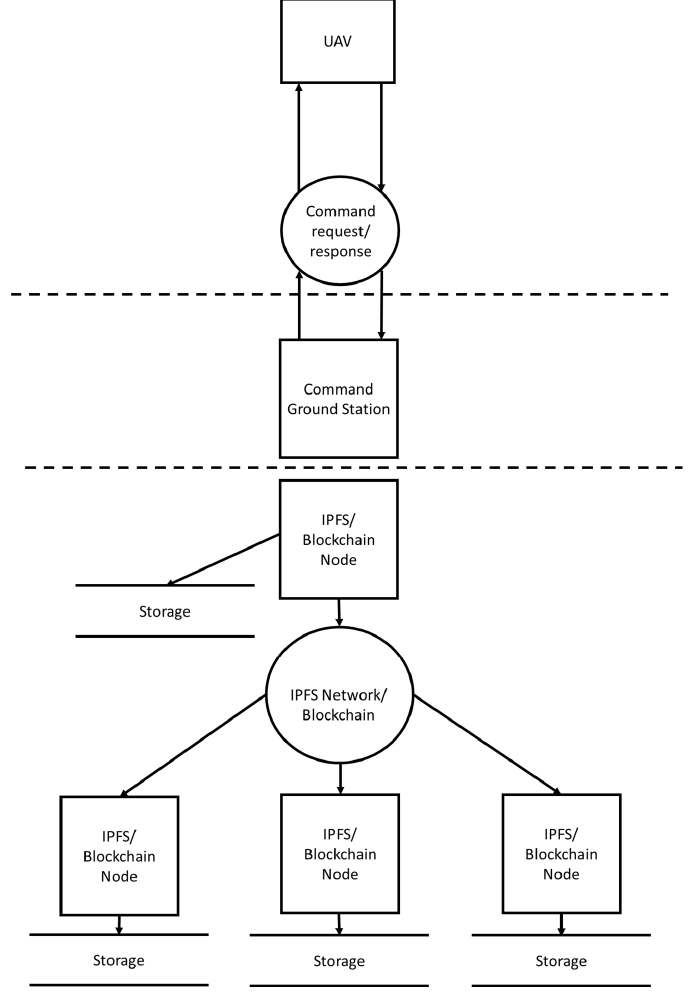
Figure 8. Security threat analysis for the proposed system.